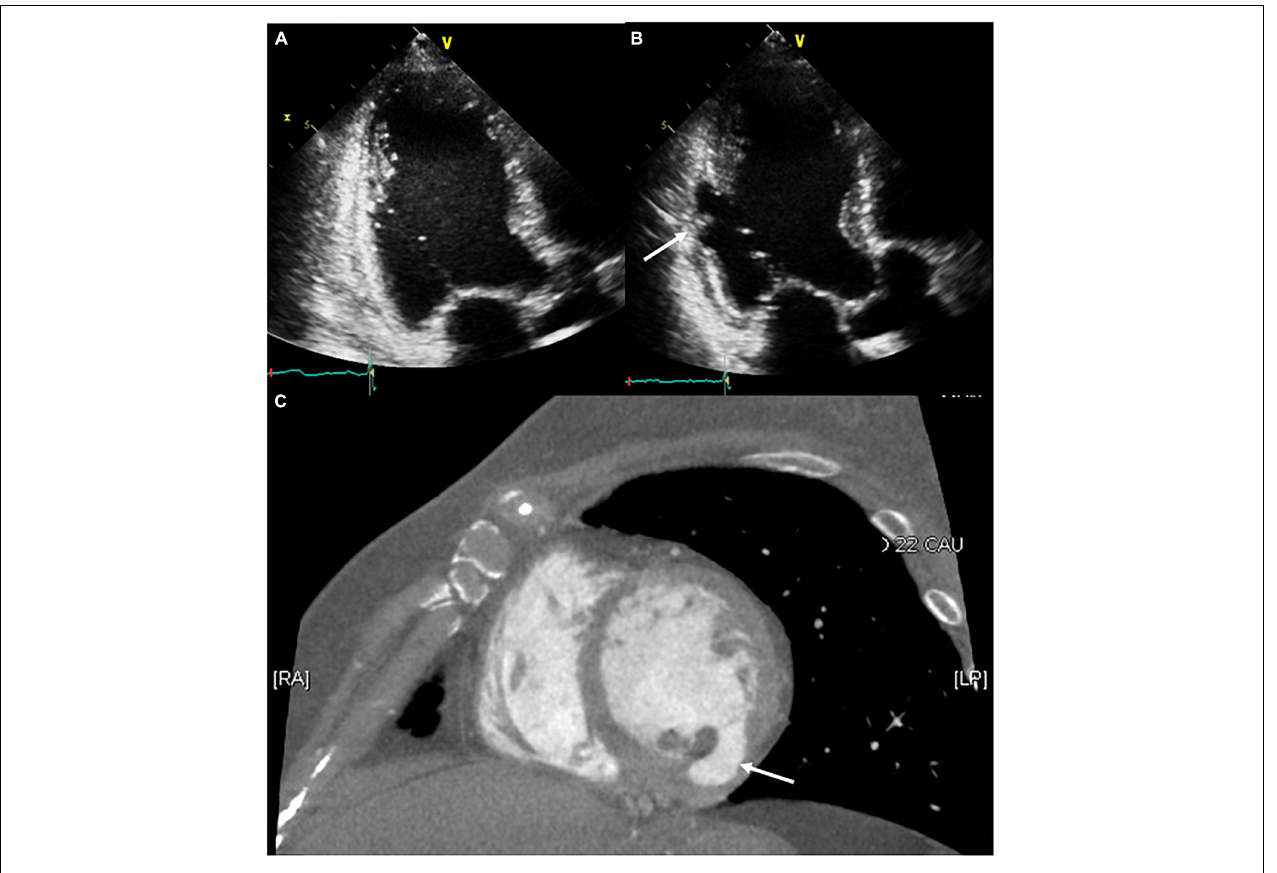
FIGURE 3 | Serial follow-up of the ablation site using transthoracic echocardiography. (A) The day after the procedure, no structural changes around the ablation site were observed. (B,C) After 2 months of follow-up, the development of a pseudoaneurysm on the ablation site (white arrow) was confirmed through transthoracic echocardiography and contrast-enhanced computed